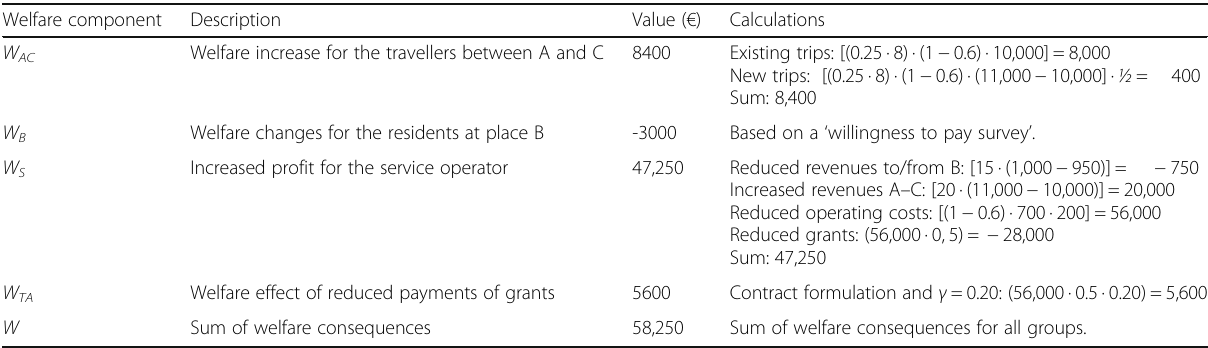
Table 3 Annual welfare consequences for the involved groups Welfare